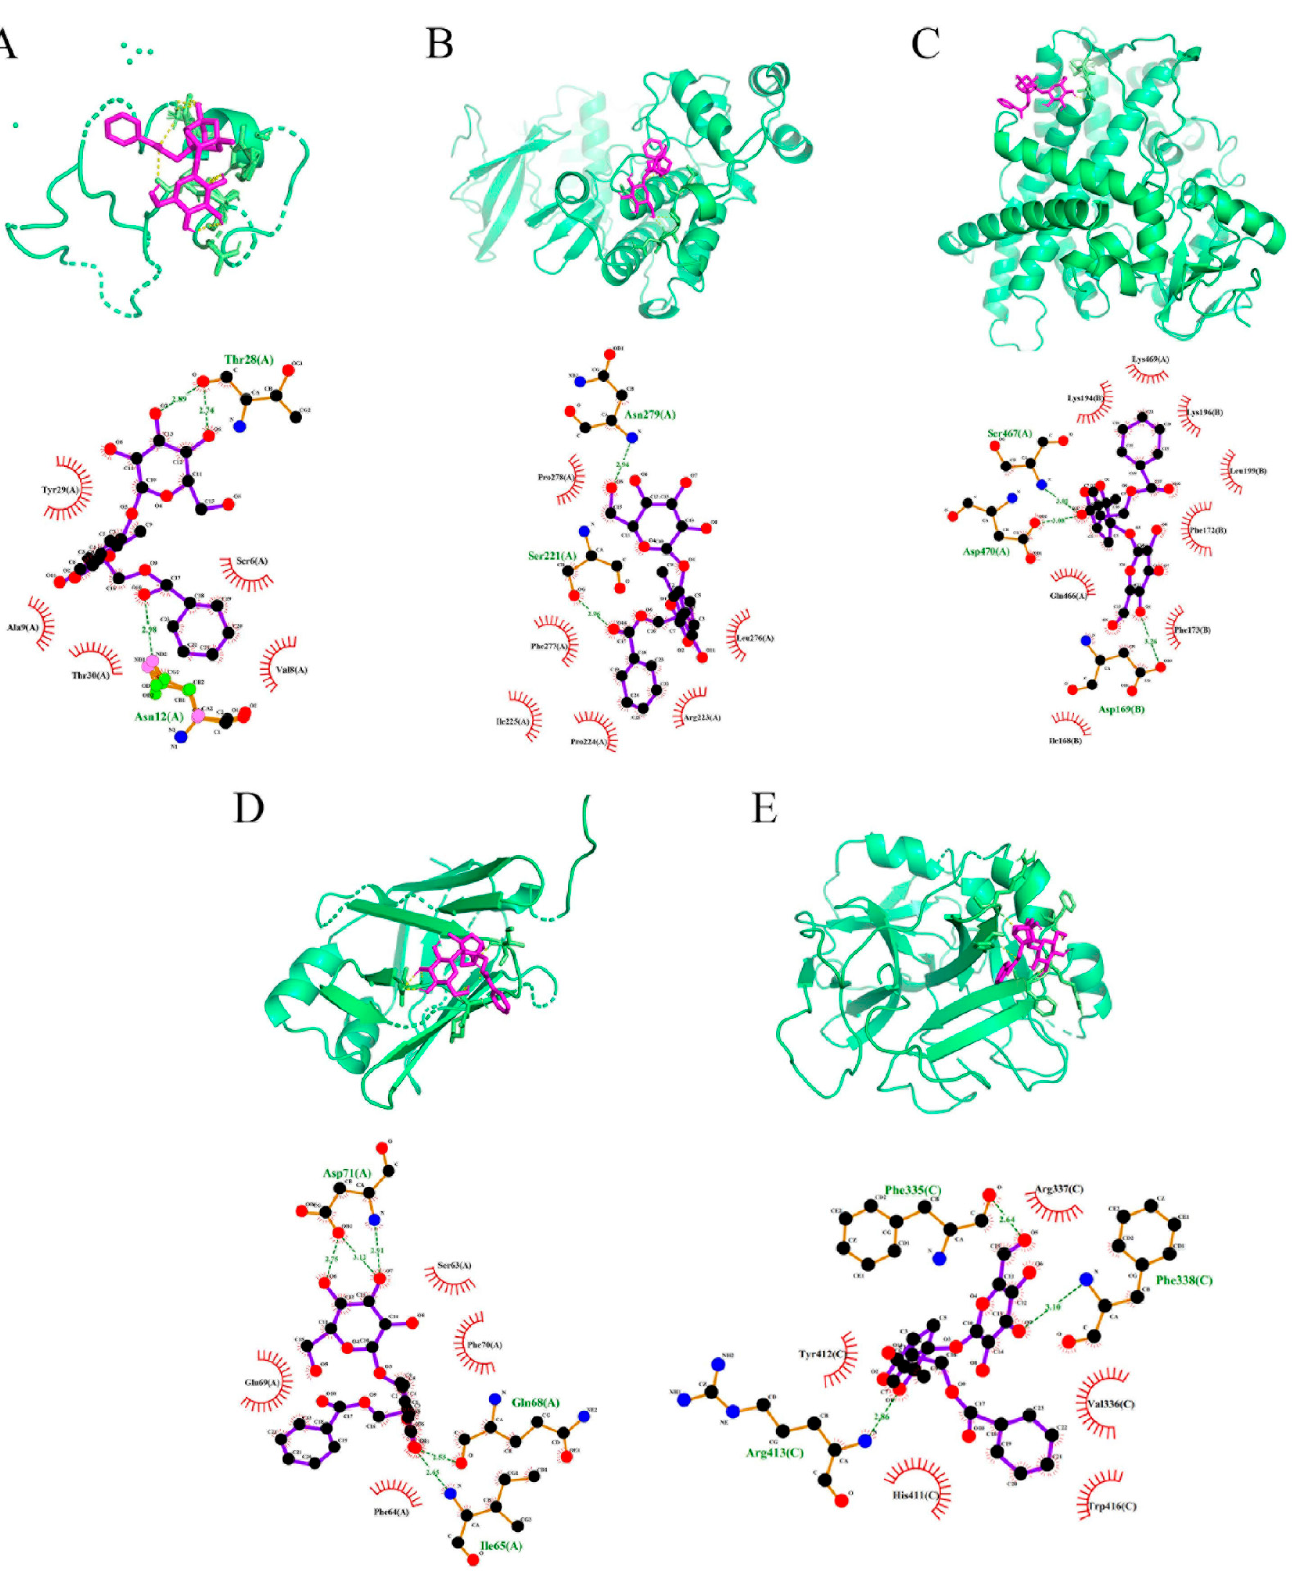
Figure 6. Molecular docking results of PF on main proteins. ( A ) PF-JNK; ( B ) PF-MAPK1; ( C ) PF- CYP2E1; ( D ) PF-Bcl-2; ( E ) PF-Bad.